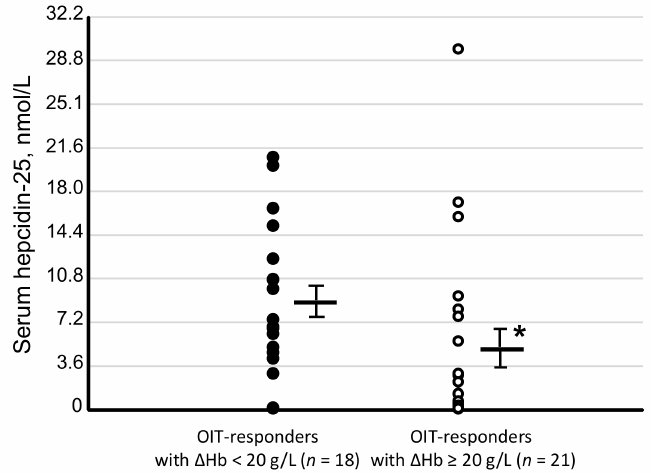
Figure 8. Serum levels of hepcidin-25 at the start of OIT between 21 OIT-responders with ∆ Hb ≥ 20 g/L and 18 OIT-responders achieving target Hb but ∆ Hb < 20 g/L at 3 months after OIT. Serum levels of hepcidin-25 at the start of OIT were significantly lower in the 21 OIT-responders with ∆ Hb ≥ 20 g/L than those in the 18 OIT responders who achieved target Hb (120–130 g/L) but ∆ Hb < 20 g/L. Comparison of two nonparametric data groups was analyzed by the Mann–Whitney U test. White circle: OIT-responders with ∆ Hb ≥ 20 g/L, black circle: the 18 OIT-responders with ∆ Hb < 20 g/L. * p < 0.05 vs. OIT-responders with ∆ Hb < 20